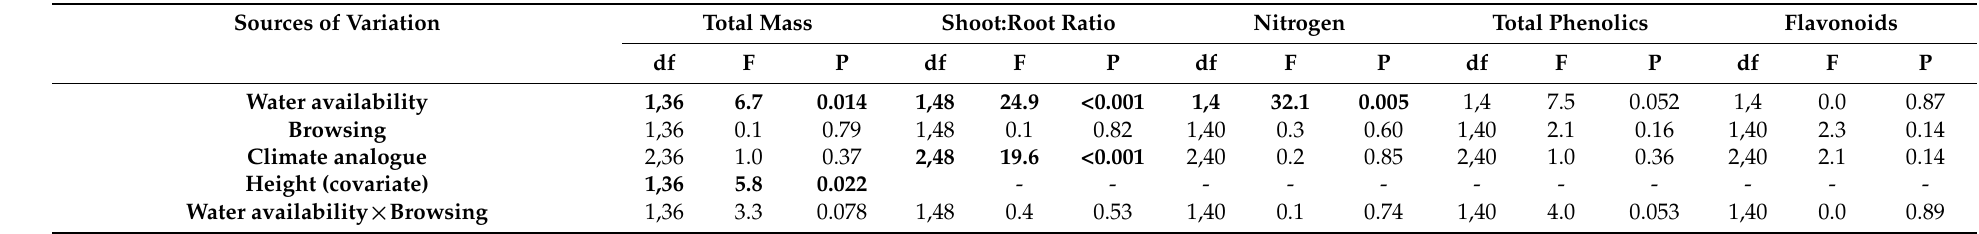
Table A2. ANOVA summary table for evaluating the effects of simulated winter browsing, water availability, seedling climate analogue (2018, 2050, 2080 analogues) and their interaction on black cherry ( Prunus serotina Ehrh.) total mass, shoot:root ratio and chemical composition (nitrogen, total phenolics and flavonoids concentration). Seedlings were grown under different levels of water availability during a ten week greenhouse